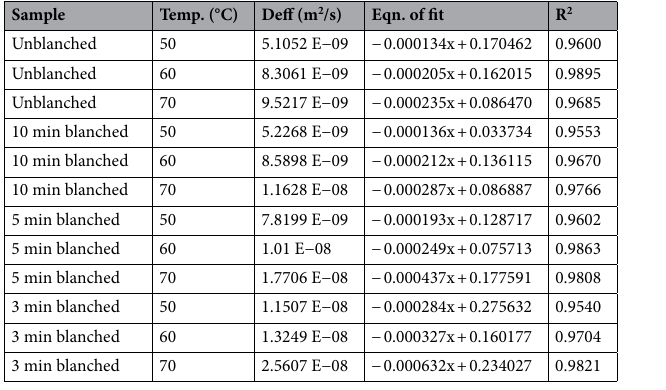
Table 1. Effective moisture diffusivities of